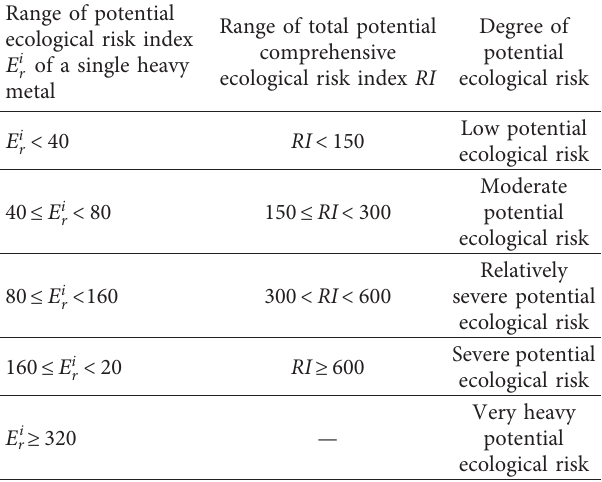
Table 1: Degrees of potential risks corresponding to various values of the potential risk index ( E ri ) and total potential ecological risk index ( RI ).